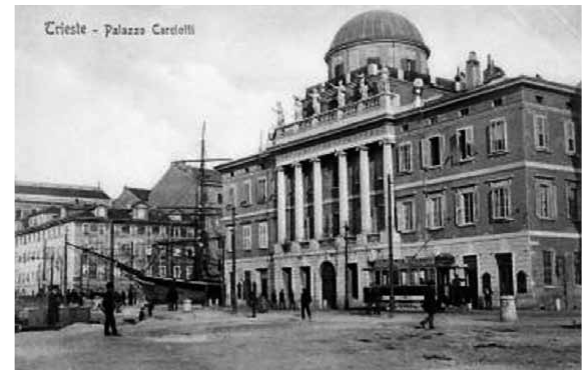
fig. 3. Carciotti Palace (photo by Stengel & Co.)